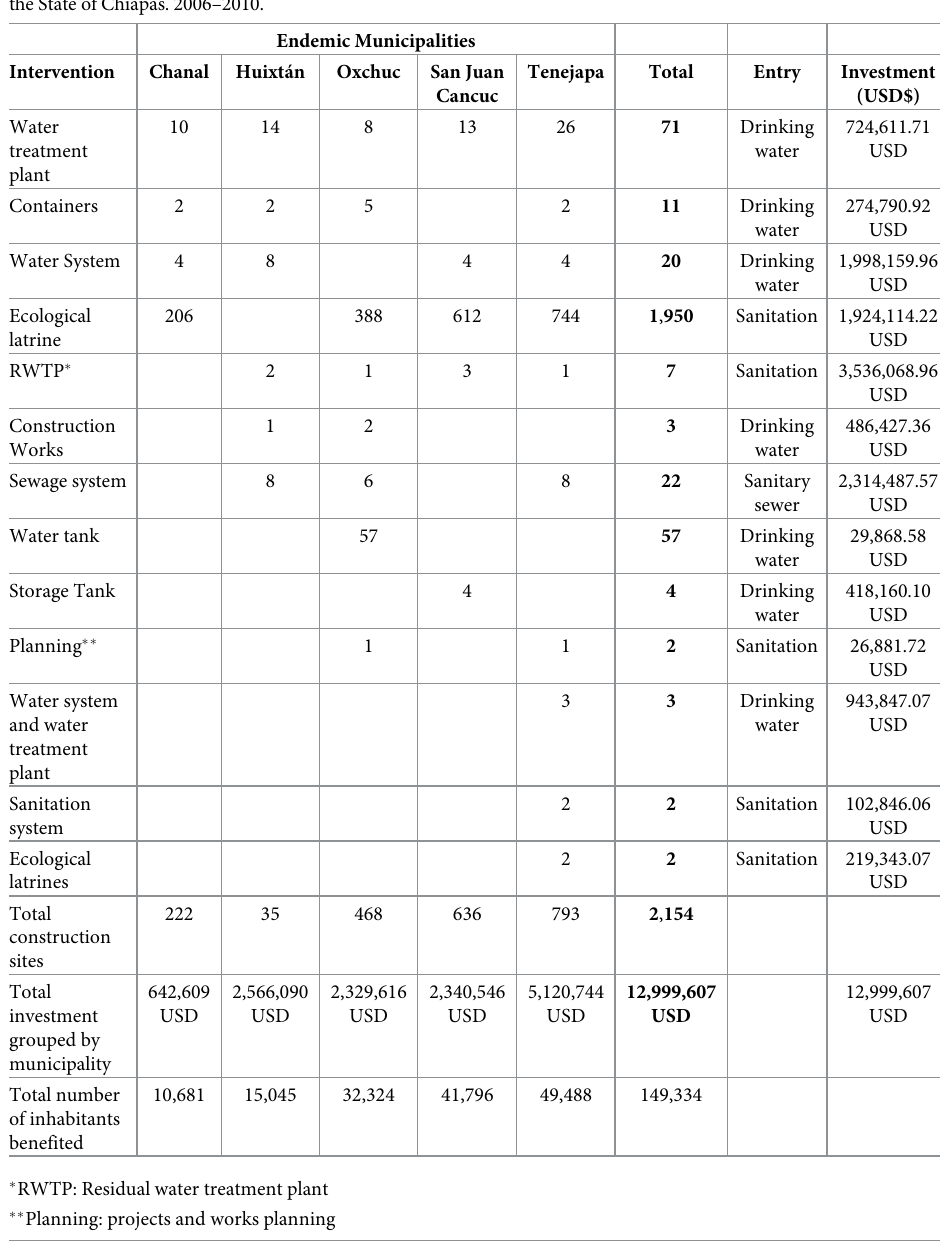
using the Bilamellar Rotation technique performed by WHO/PAHO certified surgeons. From 2012 to 2017, TT surgery was only performed in the Capital City of Chiapas, Tuxtla Gutierrez (Chiapas) by oculoplastic surgeons supporting the Trachoma Program. These surgeons con- tinue supporting the Trachoma Program in the post-validation phase. All patients received 1gr of oral azythromicyn preoperation, and postoperation antibiotic was prescribed based on sur- geons’ discretion. To improve compliance and acceptance of surgery, several actions were taken in 2012 to support the patients economically: transportation to surgery sites with family